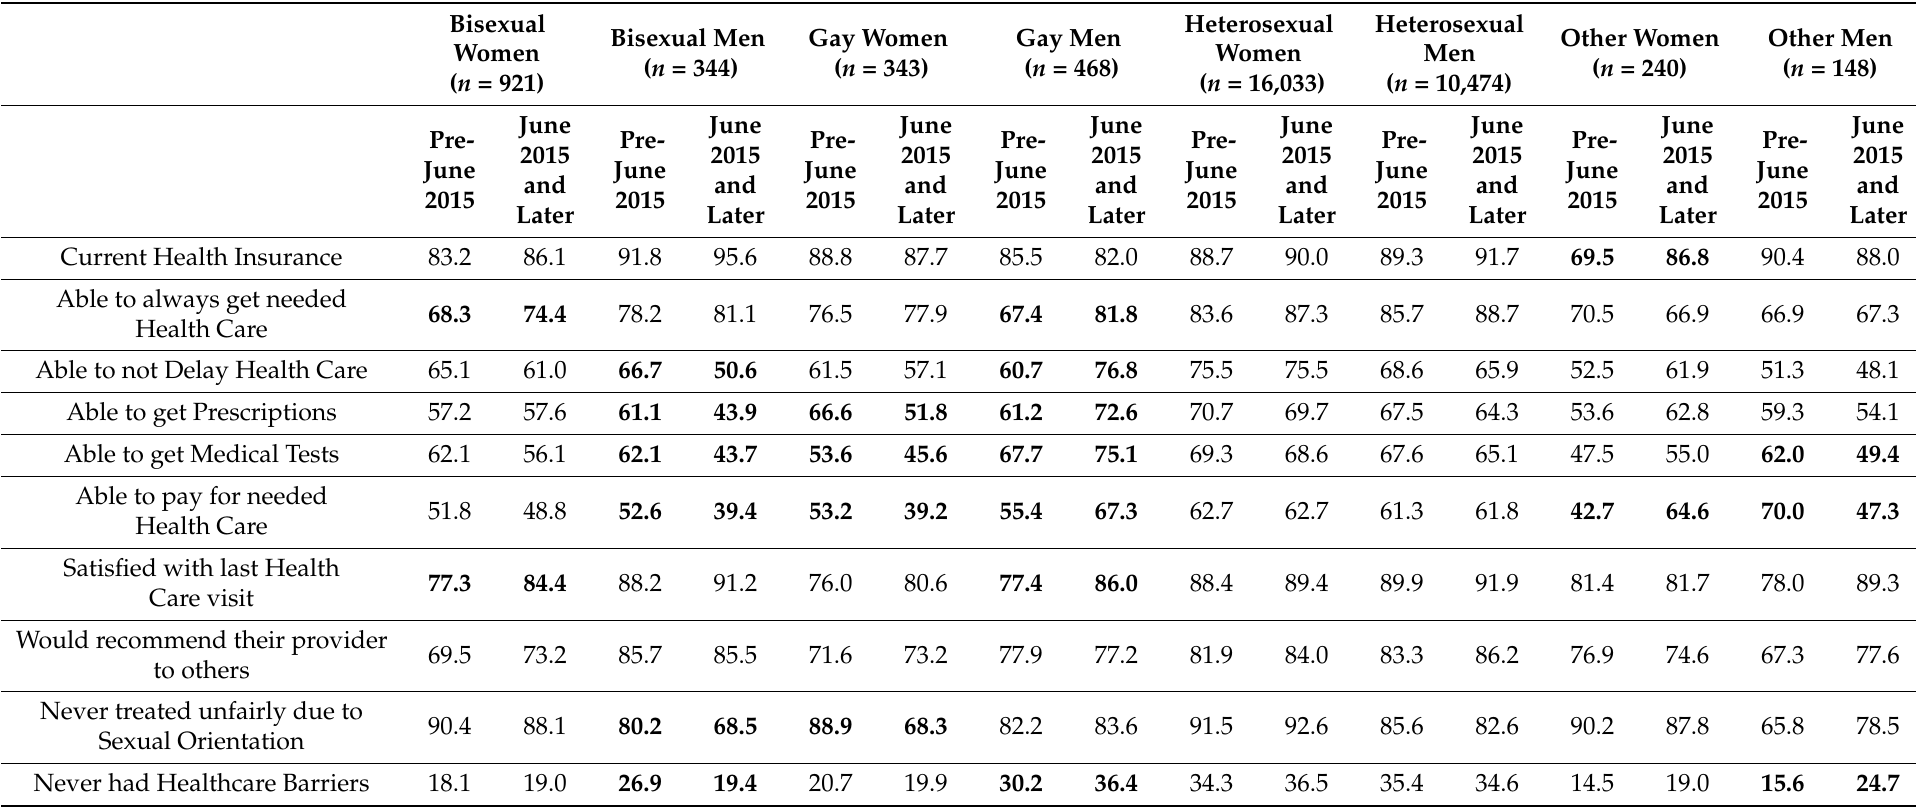
Table 1. Associations between time pre- and post- marriage equality (June 2015) and health care access and satisfaction measures, stratified by sexual identity ( n = 28,961). Tested within each sexual identity using Chi-Square test. Significant results ( p < 0.05)